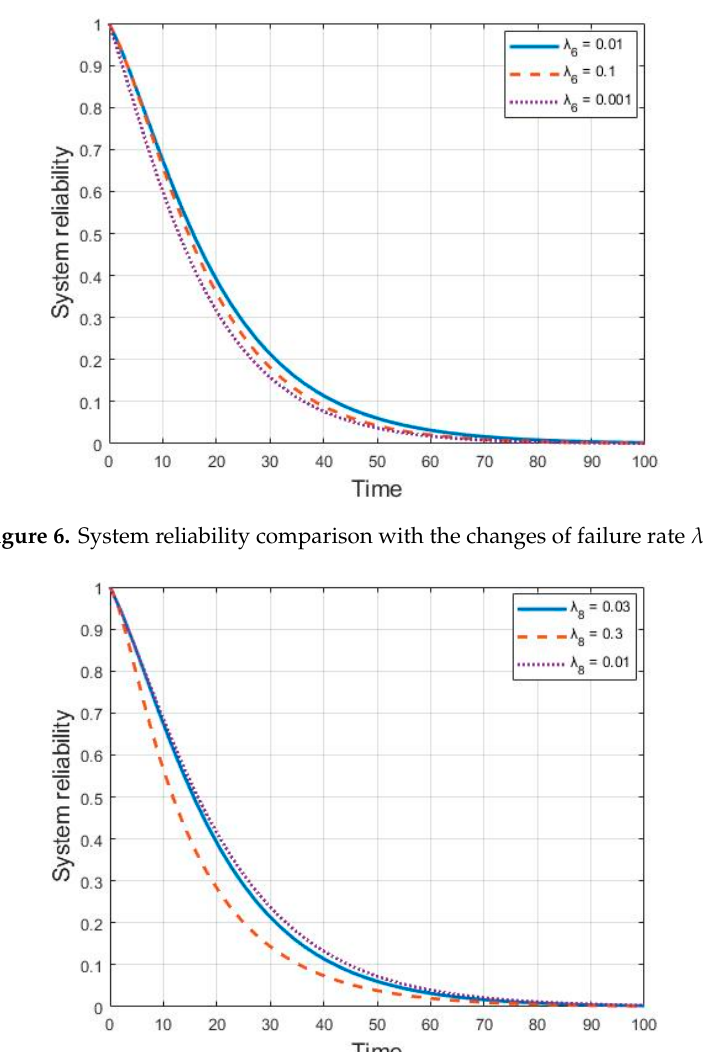
. . . Figure 5. System reliability comparison with the changes of failure rate 𝜆 (cid:2872) . Figure 5. System reliability comparison with the changes of failure rate 𝜆 (cid:2872) . Figure 5. System reliability comparison with the changes of failure rate λ 4 . Figure 5. System reliability comparison with the changes of failure rate 𝜆 (cid:2872) .